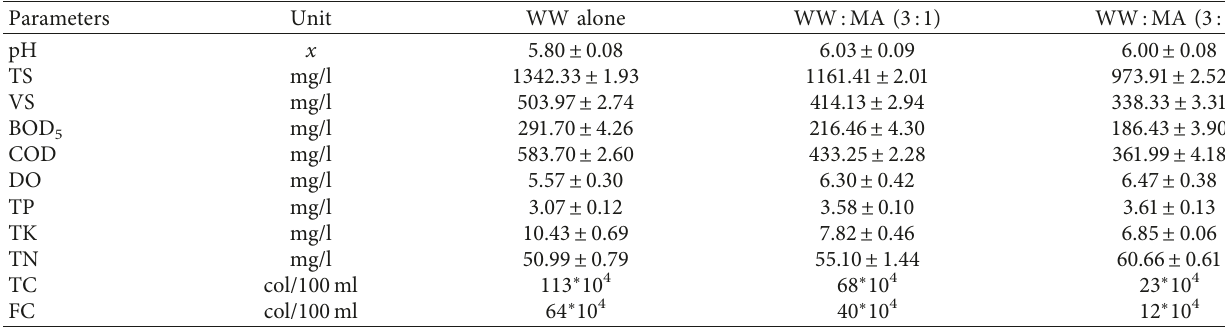
Table 3: Characteristics of feedstock after digestion.